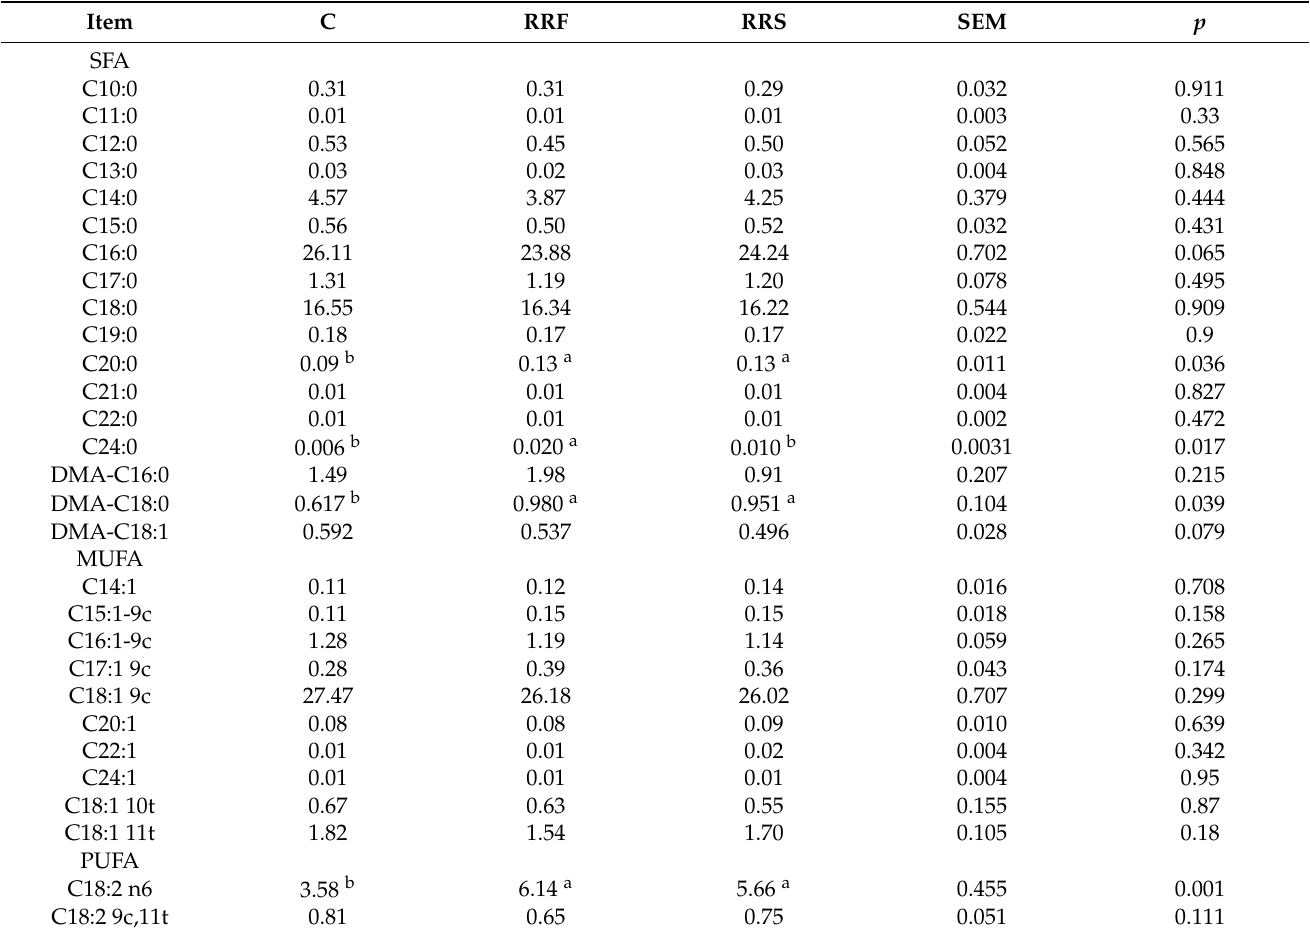
Table 4. Effect of rosemary residue intake on fatty acid profile of Barbarine lamb meat (mg FA/100 g FA).